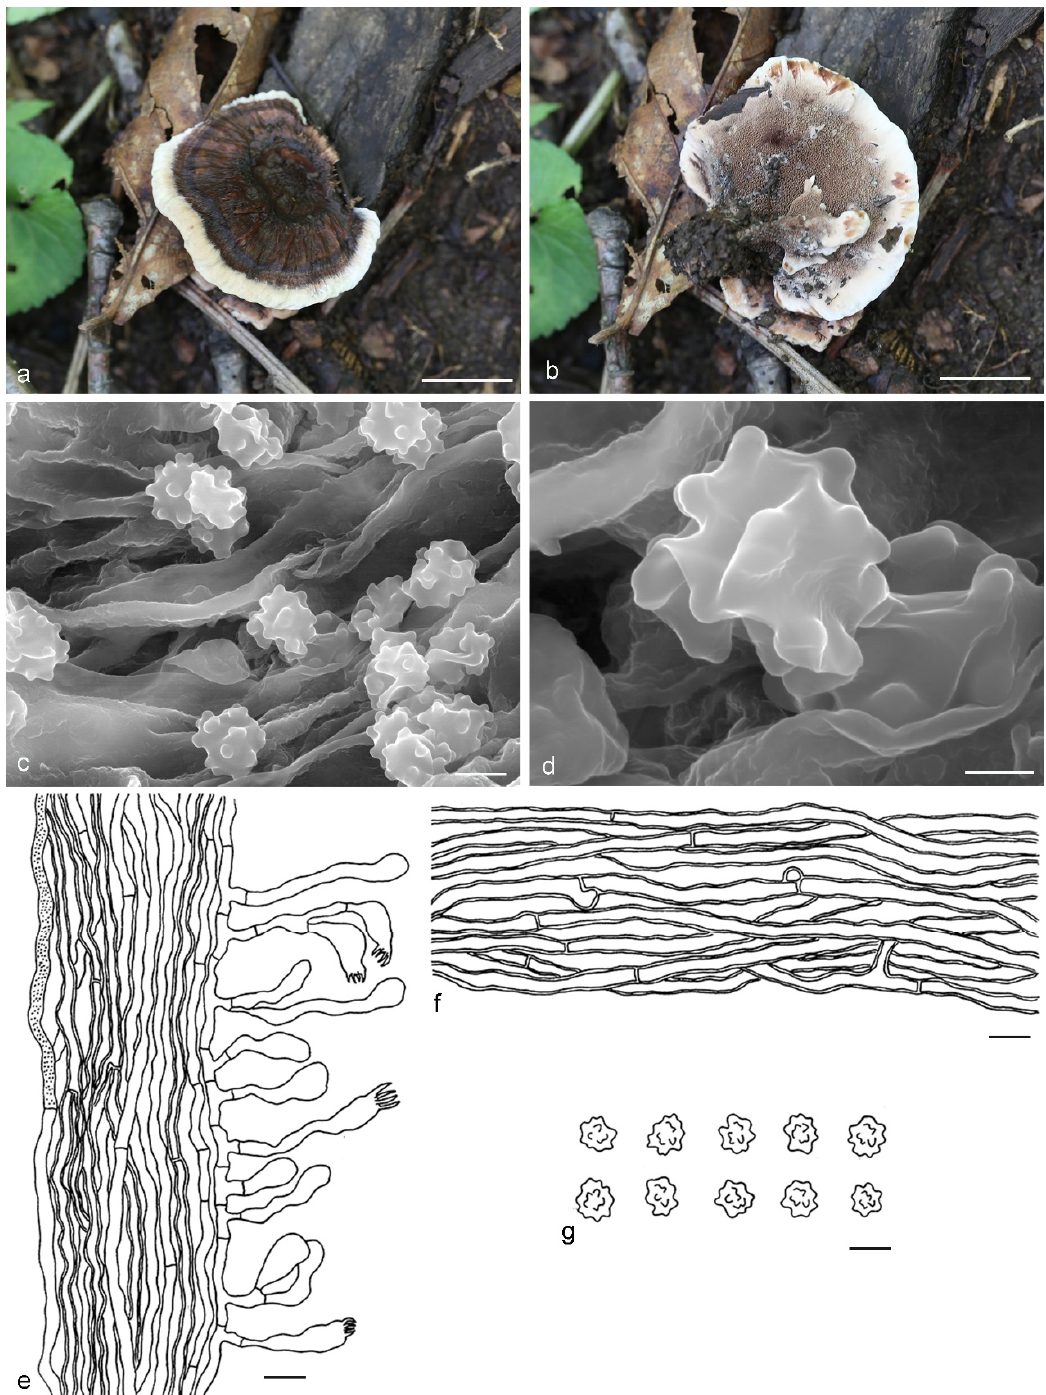
Figure 7. Hydnellum fibulatum. ( a , b ): Basidiocarps; ( c , d ): SEM of basidiospores; ( e – g ): Microscopic structures (drawn from IFP 019398); ( e ): Section of hymenophore trama with basidia; ( f ): Hyphae from pileus context; ( g ): Basidiospores. —Scale bars: ( a , b ) = 2 cm; ( c ) = 3 μm; ( d ) = 1 μm; ( e , f ) = 10 μm; ( g ) = 5 μm.